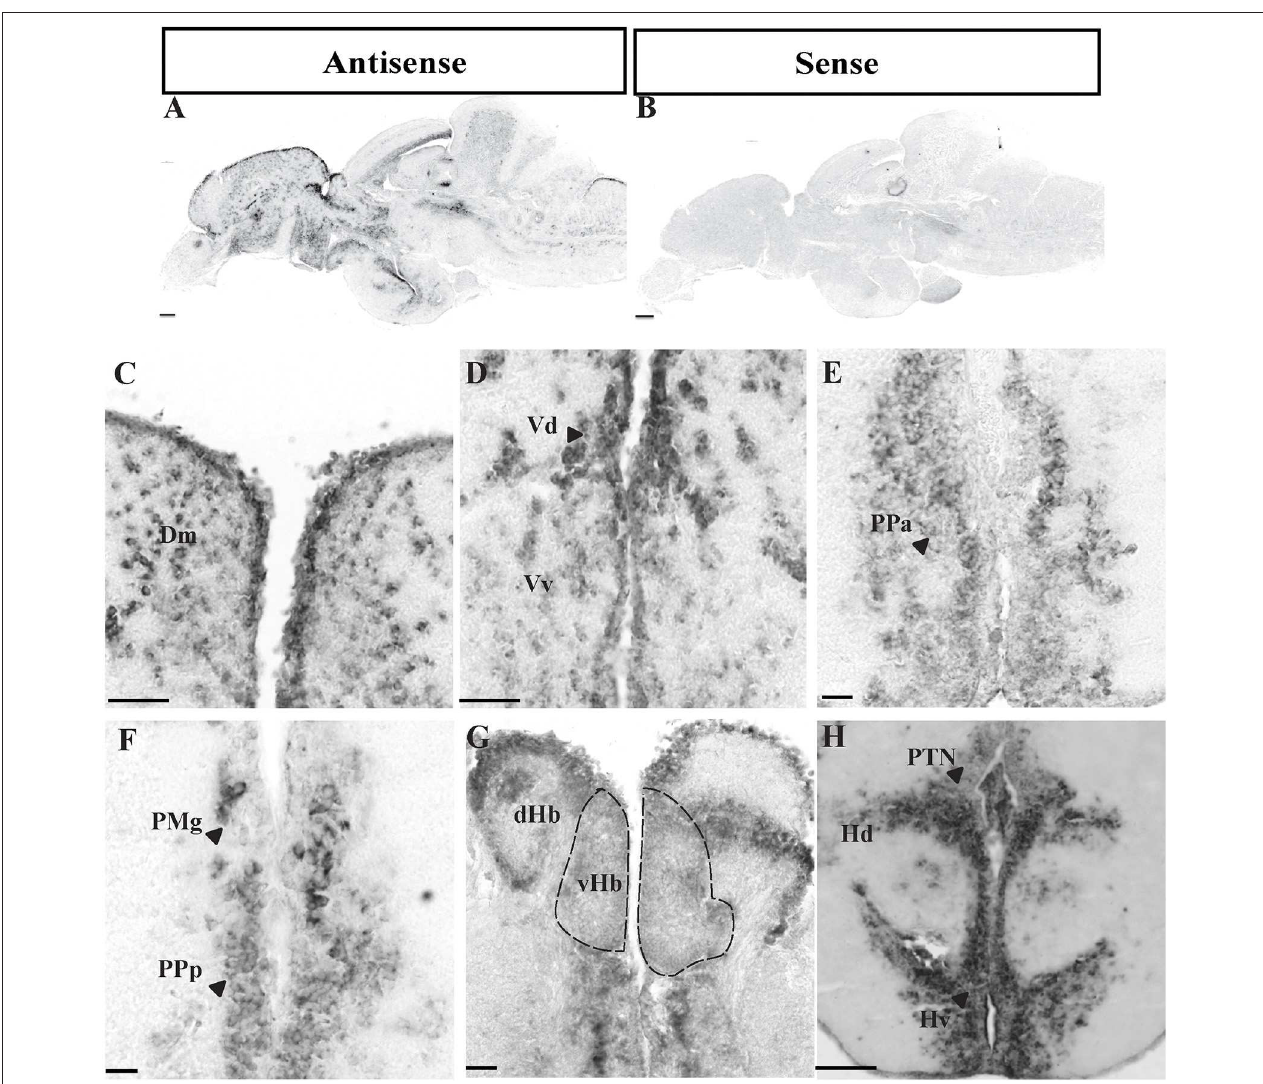
FIGURE 2 | Expression of oprm1 mRNA in the brain of zebrafish. Photomicrographs showing expression of oprm1 genes in sagittal (A,B) and coronal sections (C–H) of zebrafish brain. (A) Antisense probe for oprm1 gene showed positive signal and (B) Sense probes for oprm1 gene showed no signals. (C) Medial zone of dorsal telencephalic area, (D) Dorsal and Ventral nucleus of ventral telencephalic area, (E,F) Anterior and posterior part of parvocellular preoptic area, (G) Habenula area, and (H) Periventricular hypothalamic area. N = 3, Scale bars: A–B (100 µ m) and C–H (50 µ